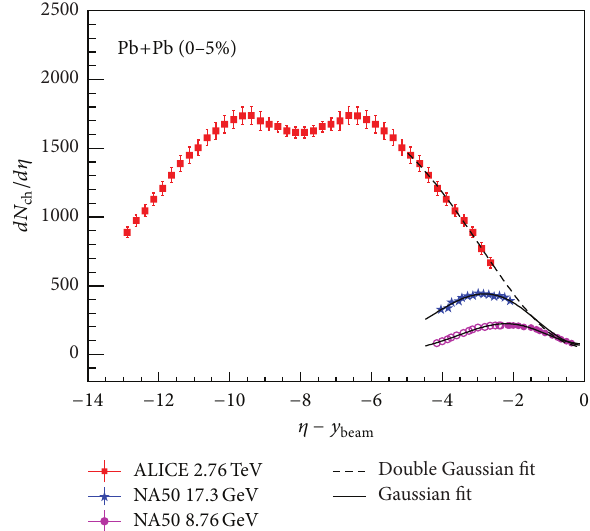
Figure 7: Charged particle multiplicity density normalized by participant pairs for Pb+Pb collisions at different energies, shown in one of the rest frames of the projectile by using 𝜂 󸀠 = 𝜂 − 𝑦